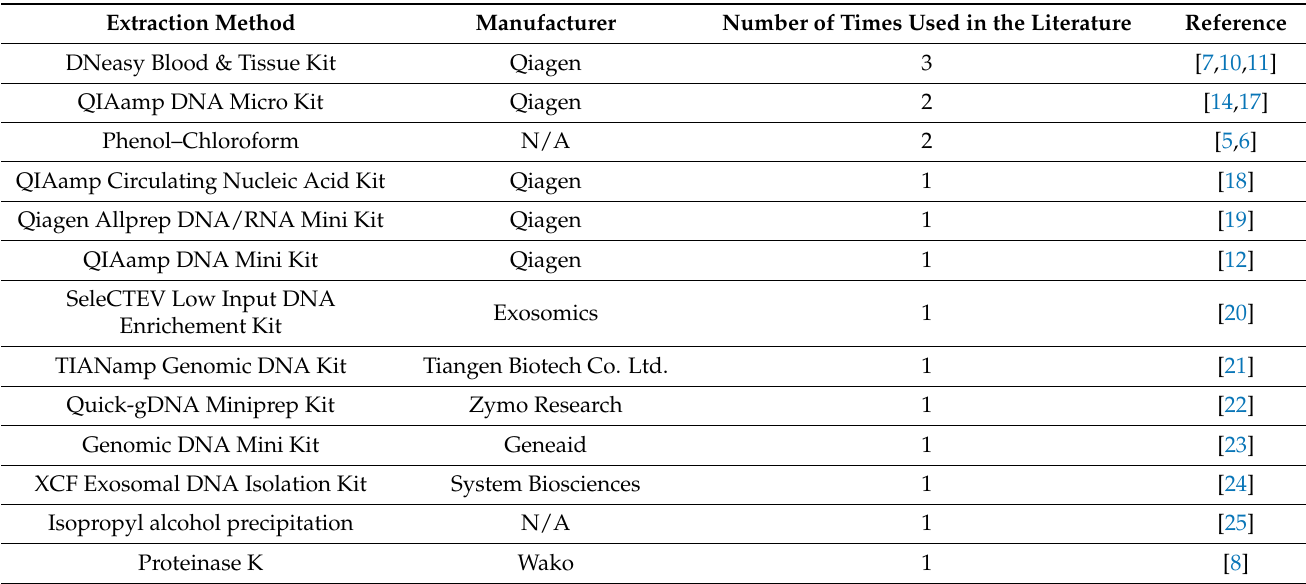
Table 1. Summary of methods used for EV-DNA extraction in the